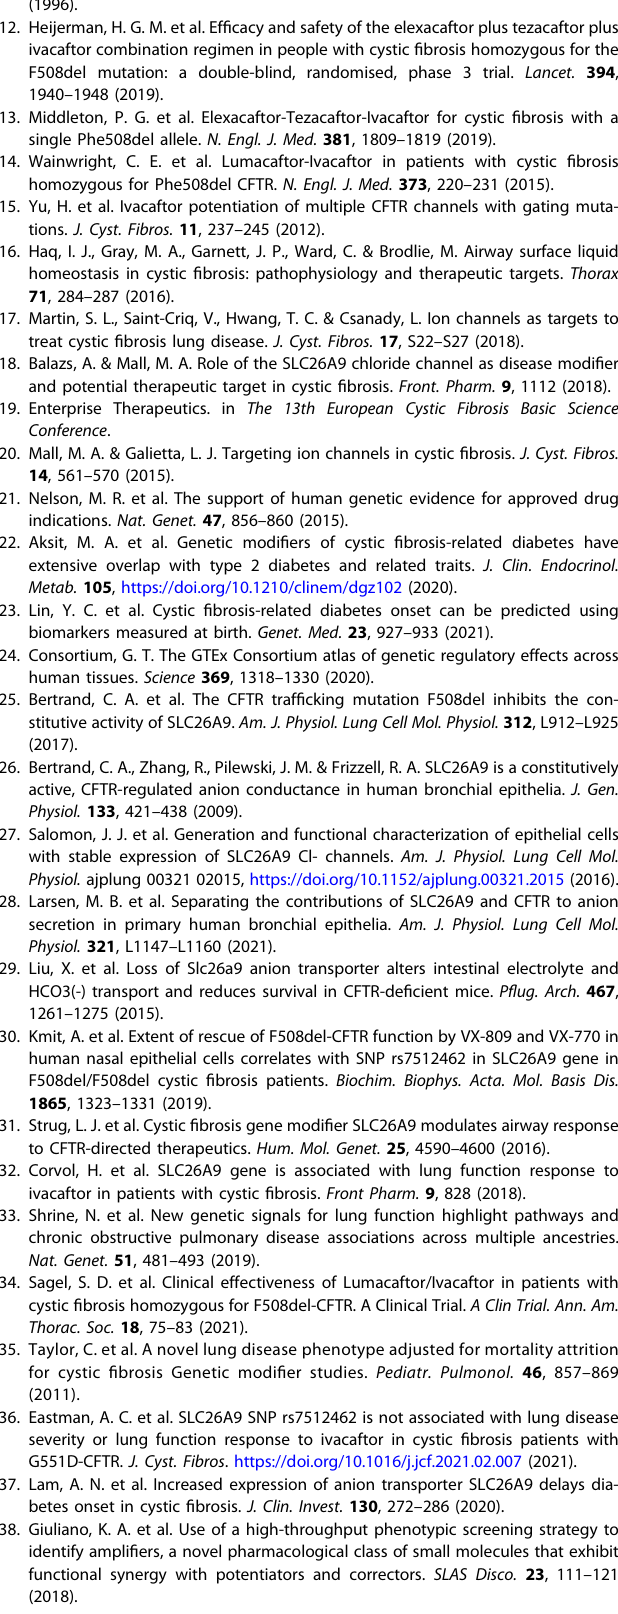
F508del mutation: a double-blind, randomised, phase 3 trial. Lancet. 394 , 1940 – 1948